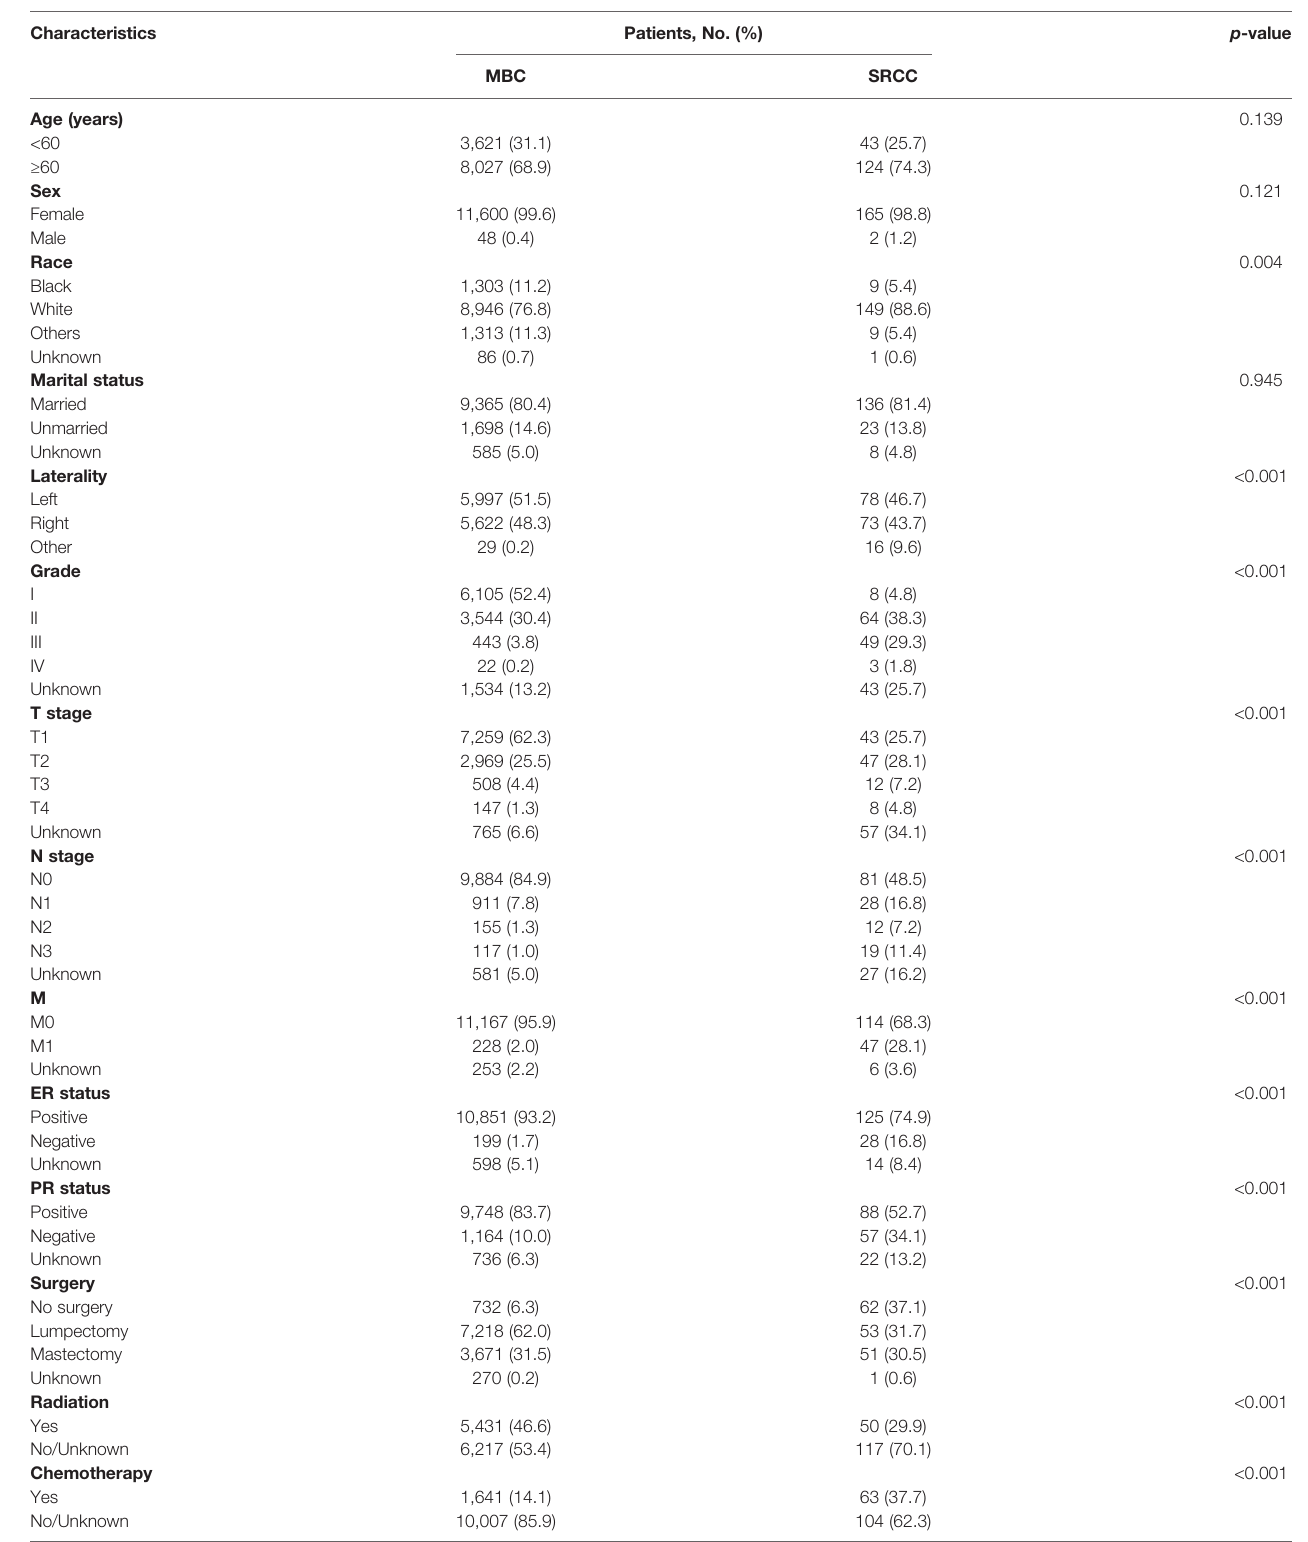
TABLE 1 | Comparison of baseline characteristics of SRCC between MBC before PSM.